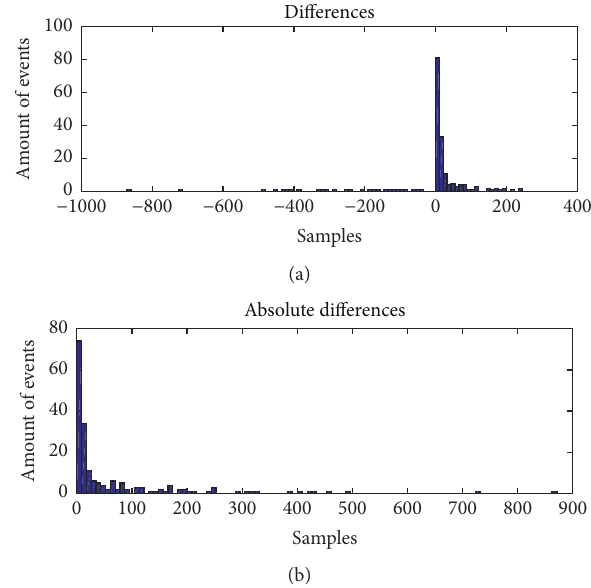
Figure 4: Histogram of differences between algorithm picks and those given by specialists: exponential function fitted (a) and histogram of absolute differences (b).